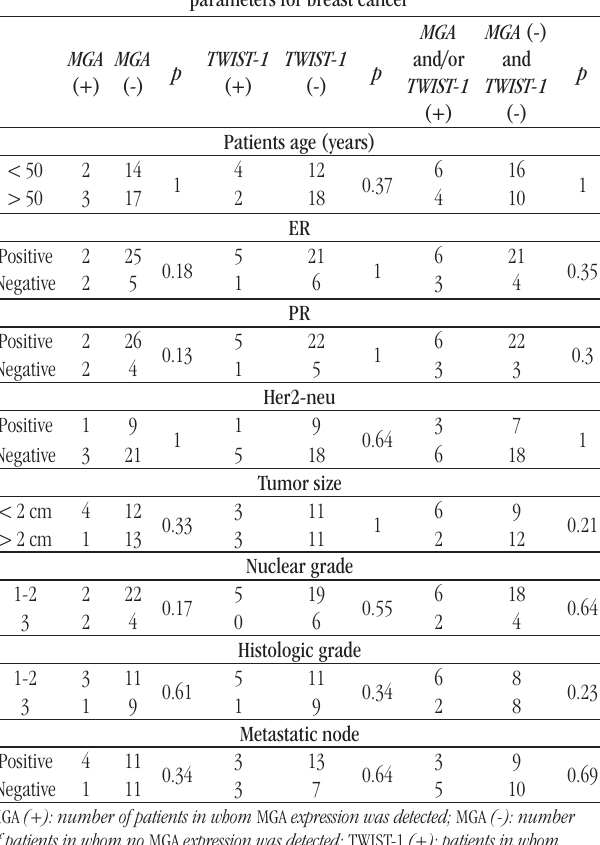
TABLE 2 – Association analysis (Fisher’s exact test) between the expression of MGA and TWIST-1 in peripheral blood and